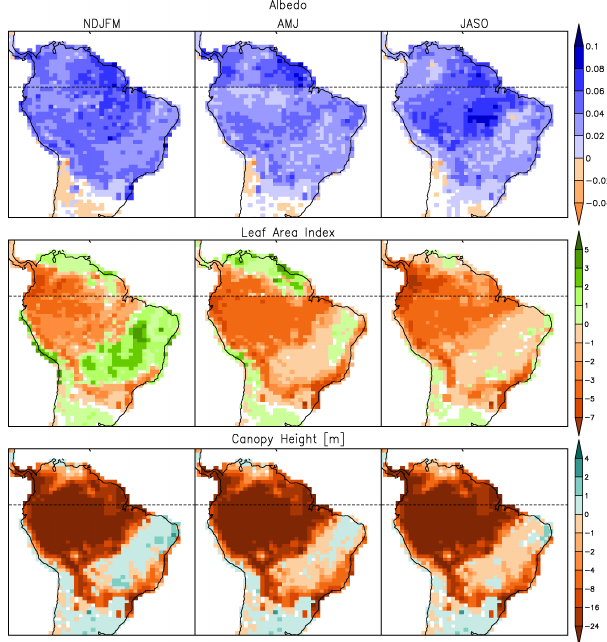
Figure 3. Changes to surface properties after deforestation in ND- JFM, AMJ and JASO; albedo (top row), leaf area index (middle row) and canopy height (m) (bottom row). Shading indicates signif- icance at the 95% confidence